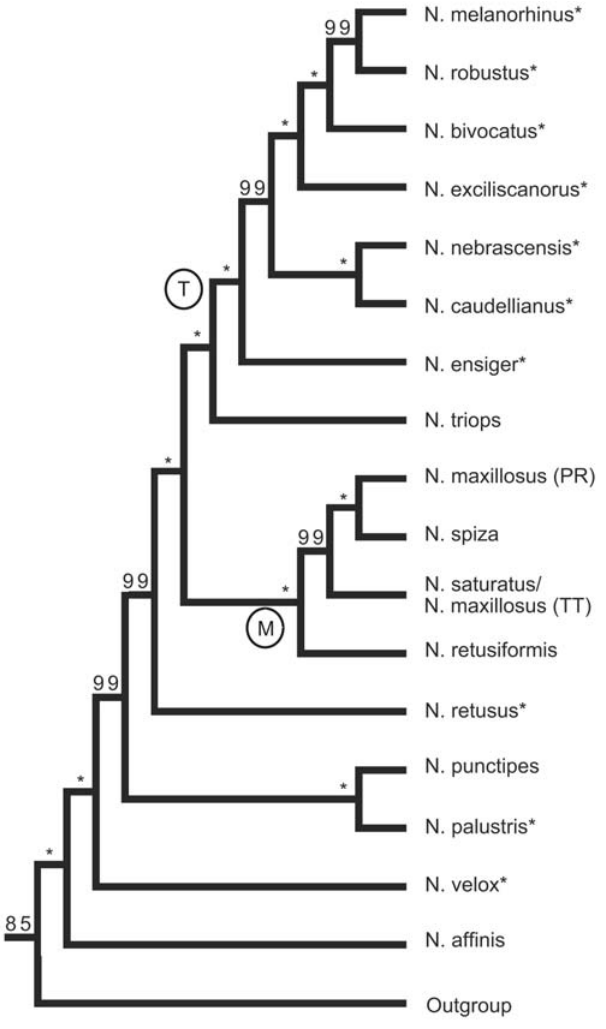
Figure 5.Total evidence tree of Neoconocephalus . Bayesian phylogeny of 17 Neoconocephalus species based on the combined analysis of the AFLP and gene trees given in Figures 1, 2, and 3. The phylogeny was pruned for visual simplification. Each tip of the pruned phylogeny represents a monophyletic group. Nodal support values are given as posterior probabilities in percent; asterisk indicate 100%. The temperate clade and the N. maxillosus clade are indicated by labels ‘T’ and ‘M’, respectively. Branch lengths are not drawn to scale. Asterisks at the species names indicates temperate life history.